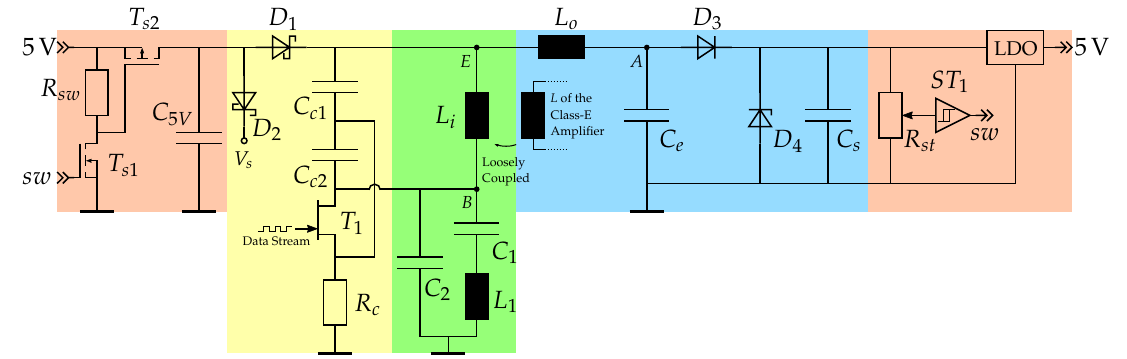
Figure 8. Transmitter electronics; the voltage at pin V s is used to supply the sensor with energy. The yellow marked circuit part corresponds to the data transmission sub-circuit, the blue marked one to the energy receiving sub-circuit, and the green marked components are the shared components for both these sub-circuits. The red marked circuit part is used for switching between the two operational steps and for supplying the 5V needed for the components like the sensor, the Schmitt trigger